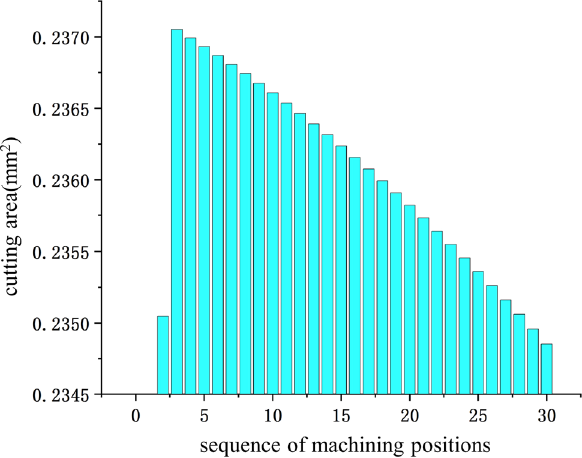
Figure 3: The cutting area under di ff erent machining